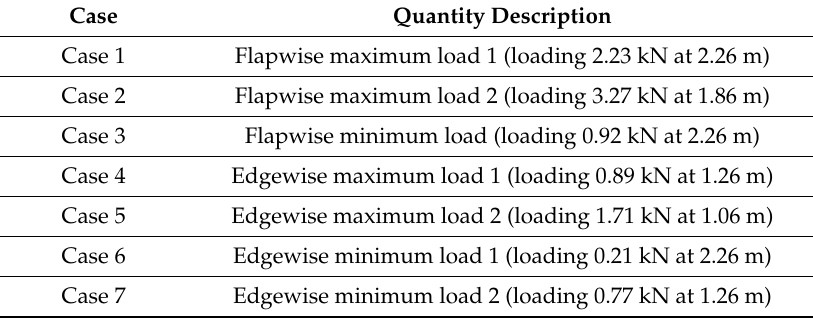
Figure 15. The test cases with testing loads at loading position: ( a ) flapwise direction and ( b ) edgewise direction. Table 6. The test cases.